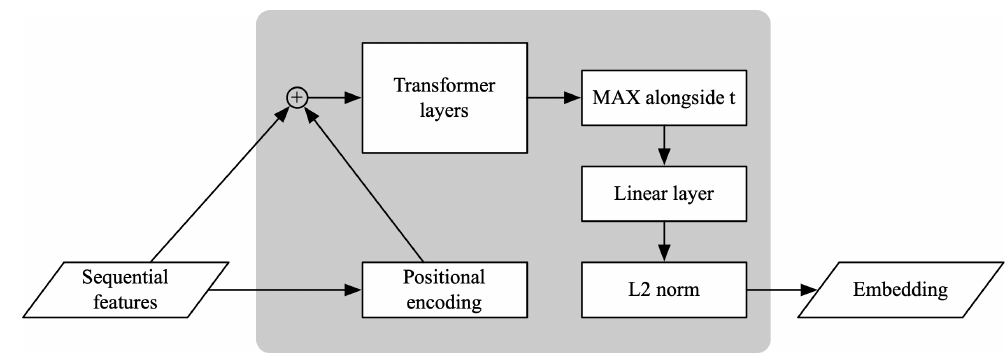
Figure 3. Sequence